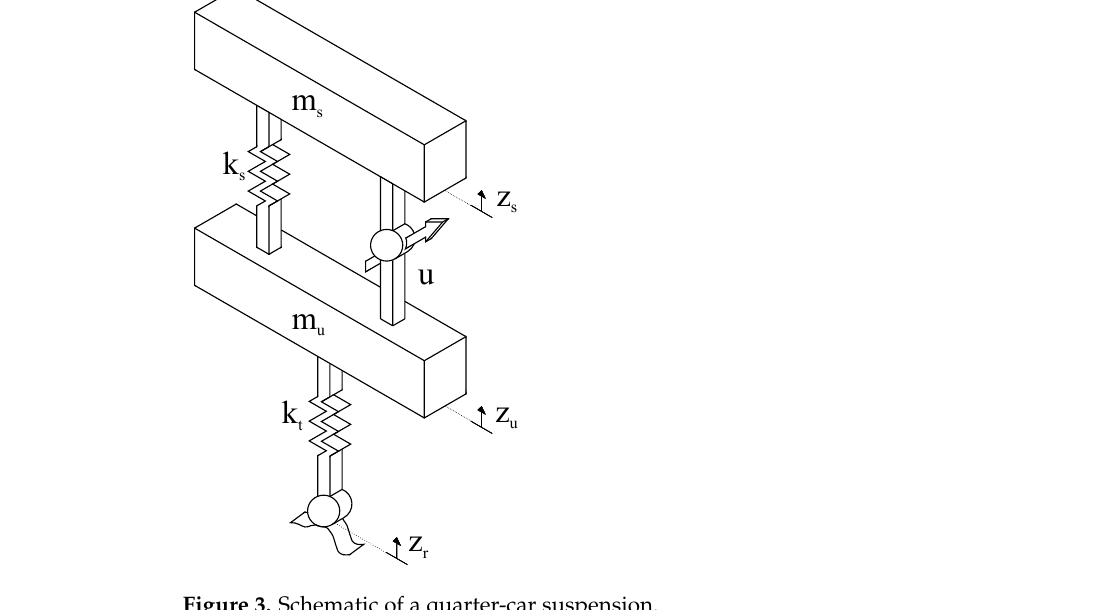
Figure 3. Schematic of a quarter-car